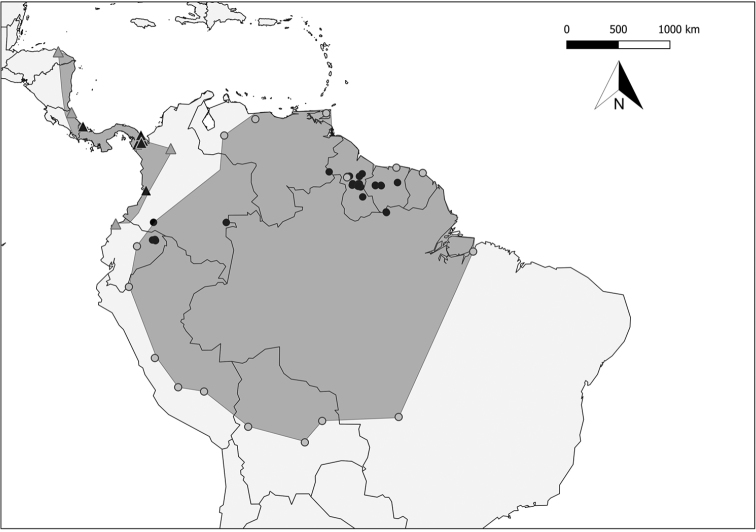
Geographic distribution of Chiroderma
gorgasi (▲) and C.
trinitatum (●) localities analyzed in our study (See Appendix 3) (gray circle) Represents marginal localities reported for C.
trinitatum and (gray triangle) C.
gorgasi reported by previous papers (Handley 1967; Pine et al. 1970; Ojasti and Linares 1971; Gardner 1976; Albuja 1989; Timm and LaVal 1998; Lim and Engstrom 2001; Genoways et al. 1981; Webster and Fugler 1984; Anderson 1997; Ochoa et al. 1988; Simmons and Voss 1998; Gardner 2008).